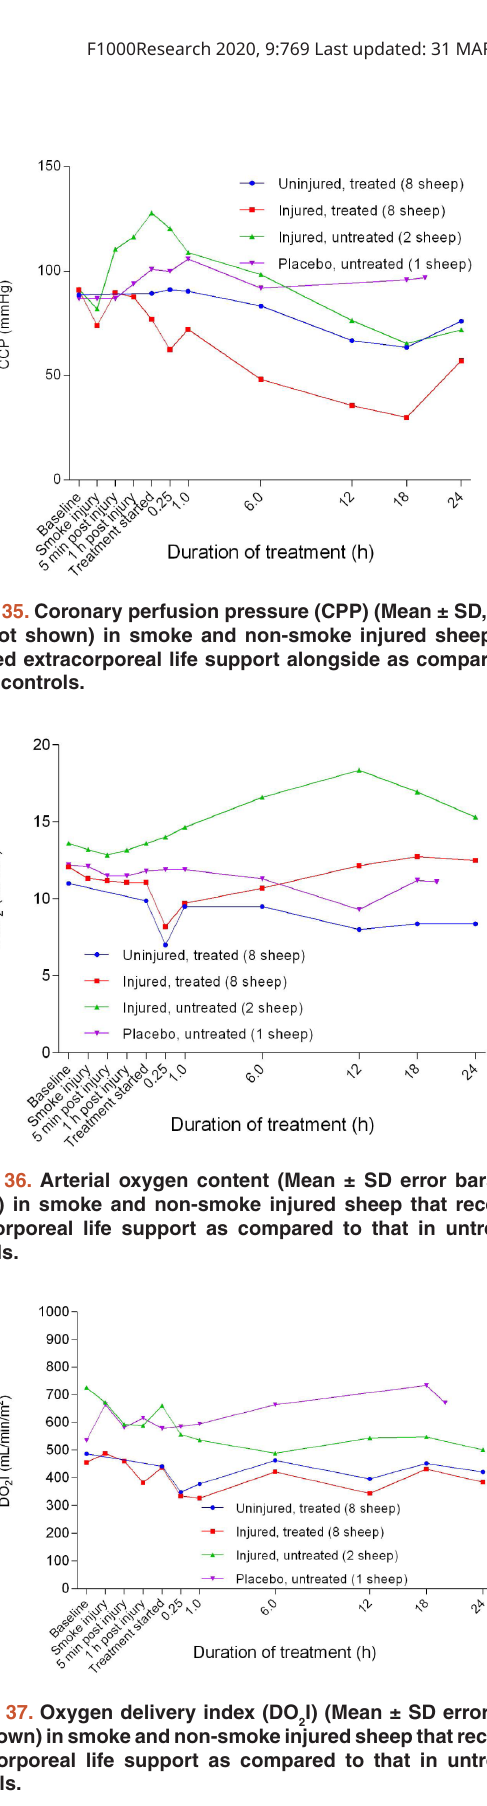
I) (Mean ± SD error bars 2